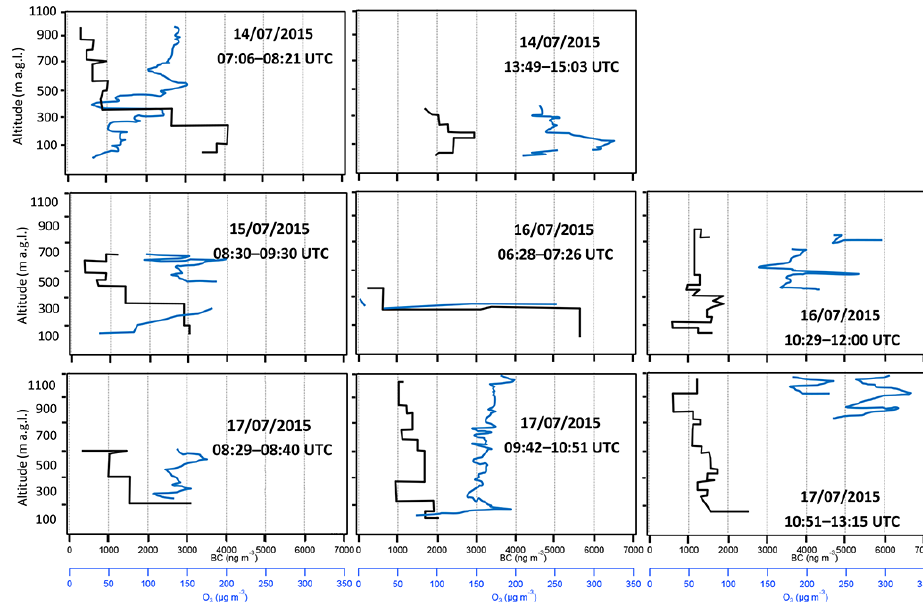
Figure 13. Vertical profiles of BC (5min time resolution) and O 3 (10s time resolution) at VIC.